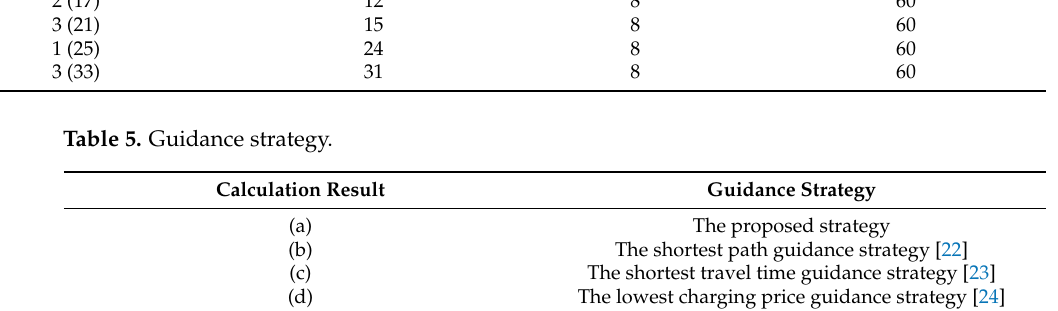
Table 6. Index type.